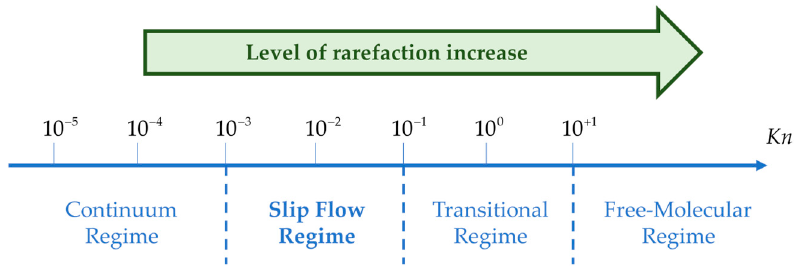
Figure 1. Classification of flow regimes based on Knudsen number.